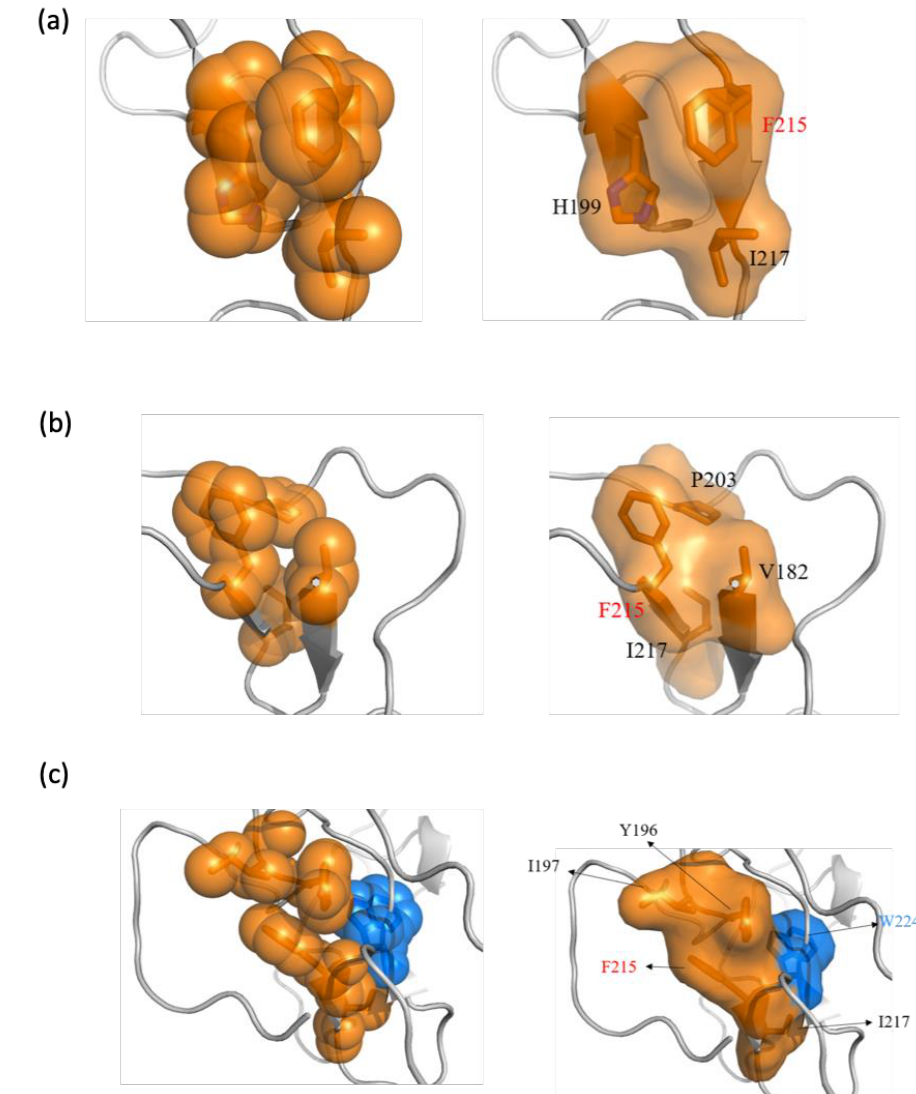
Figure 7. The hydrophobic and aromatic interaction network with the key residue Phe215 in ( a ) the CD44s stem region, cluster 1; ( b ) the CD44s stem region, cluster 2; and ( c ) the CD44v6 stem region, cluster 1. The residues involved in the hydrophobic and aromatic interactions are colored orange and are shown in sticks with spheres (left) and surfaces